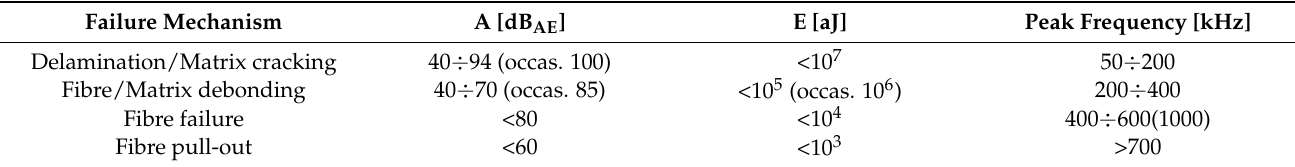
Table 5. Characterisation of reported failure mechanisms.